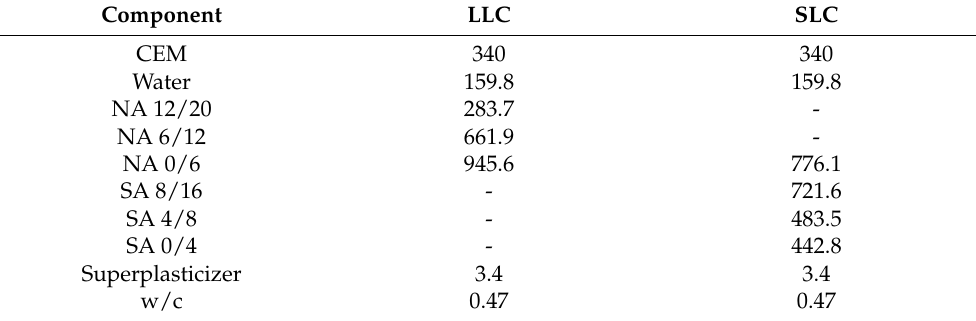
Table 3. Concrete mix proportions (kg/m 3